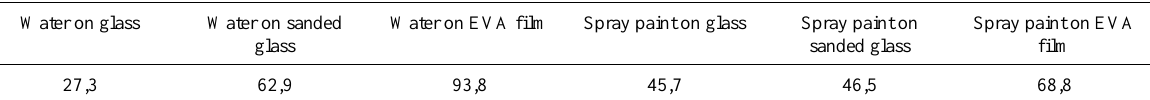
Table 1: Surface angle (°)